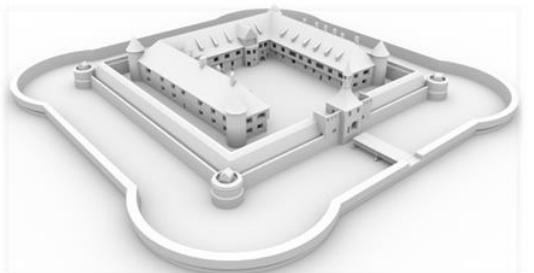
Figure 3b. 'White' model of the